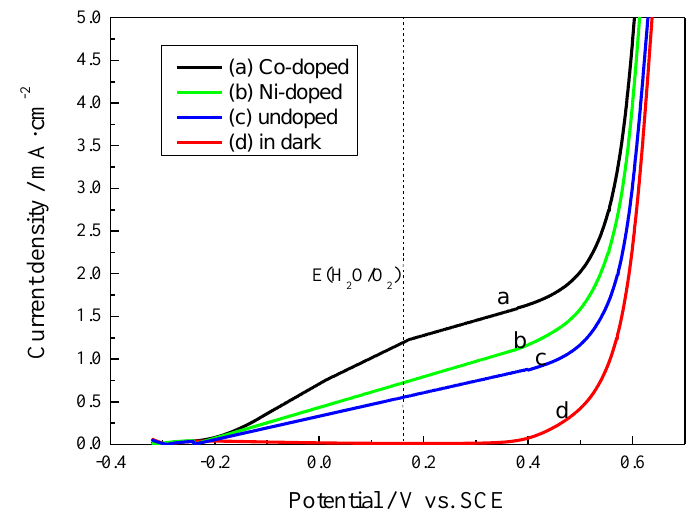
Figure 7. Current-voltage (I-V) plots of the α -Fe 2 O 3 nanorod arrays: ( a ) Co-doped α -Fe 2 O 3 under solar irradiation; ( b ) Ni-doped α -Fe 2 O 3 under solar irradiation; ( c ) undoped α -Fe 2 O 3 under solar irradiation; ( d ) undoped α -Fe 2 O 3 in dark. Table 1. Photocurrent densities of doped and undoped α -Fe 2 O 3 at a certain potential versus reversible hydrogen electrode (RHE) reported in the